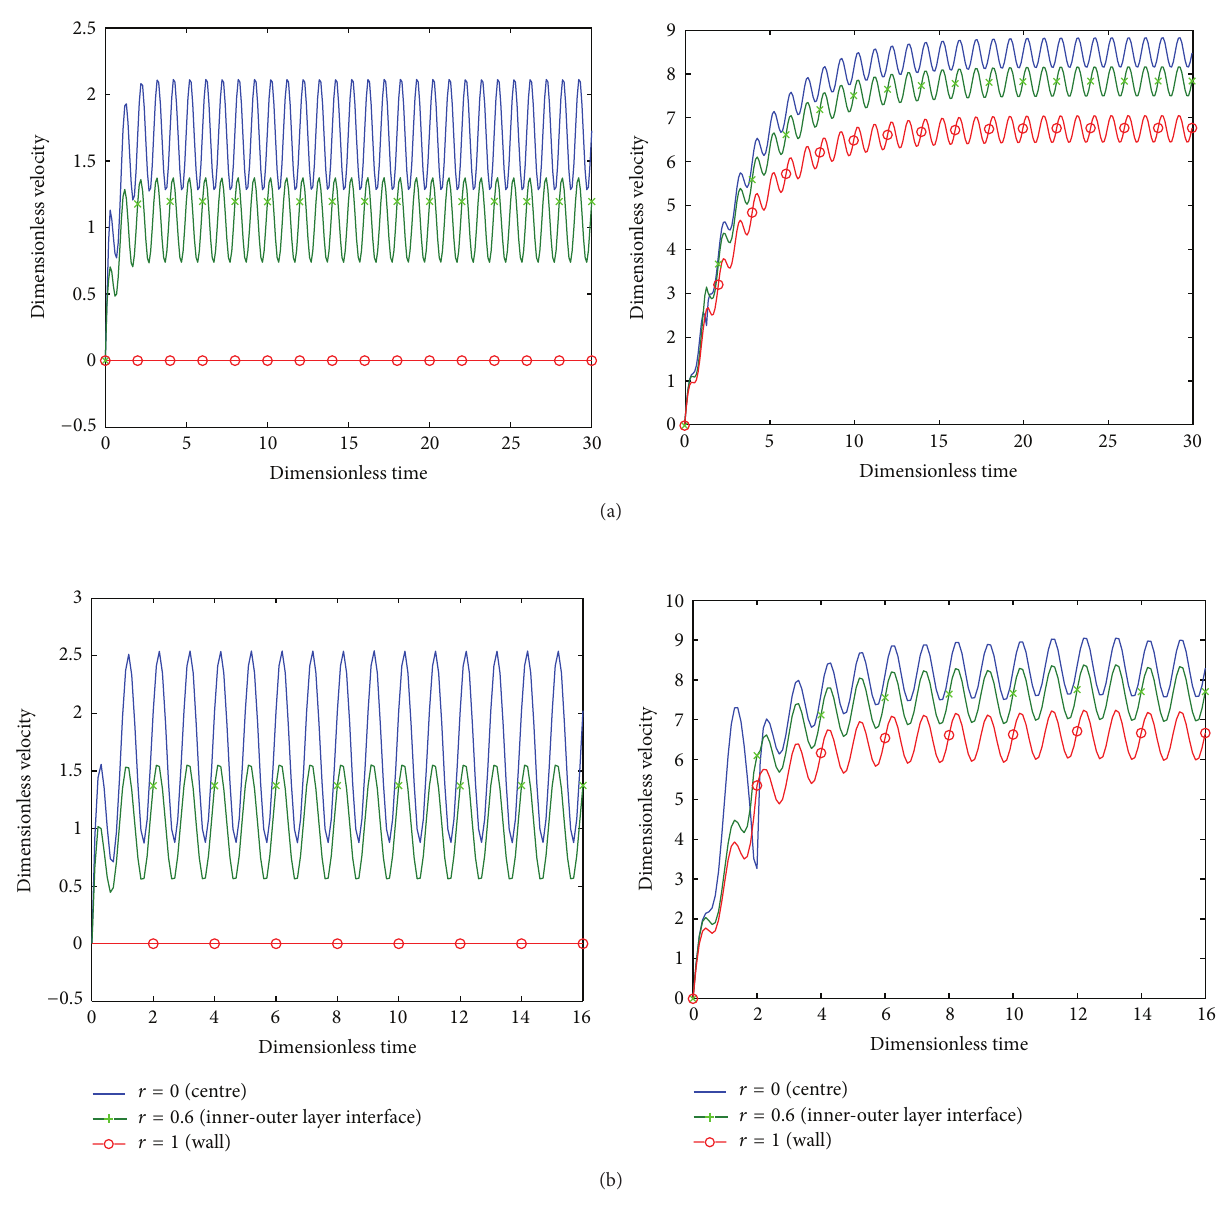
= 0 , while the graphs on the right column 𝑏